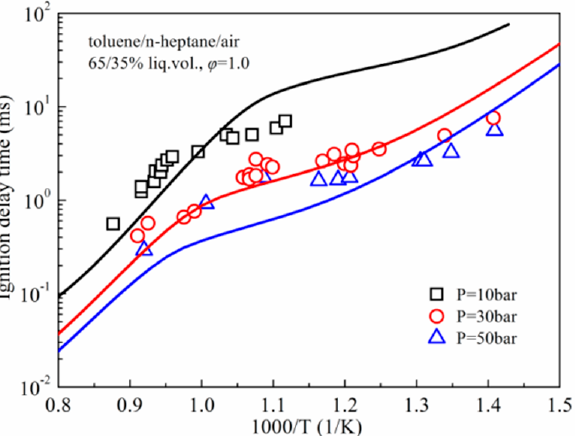
Figure 4. Comparisons between the predicted (lines) and experimental [41] (symbols) ignition delays of n-heptane/toluene/air mixtures.